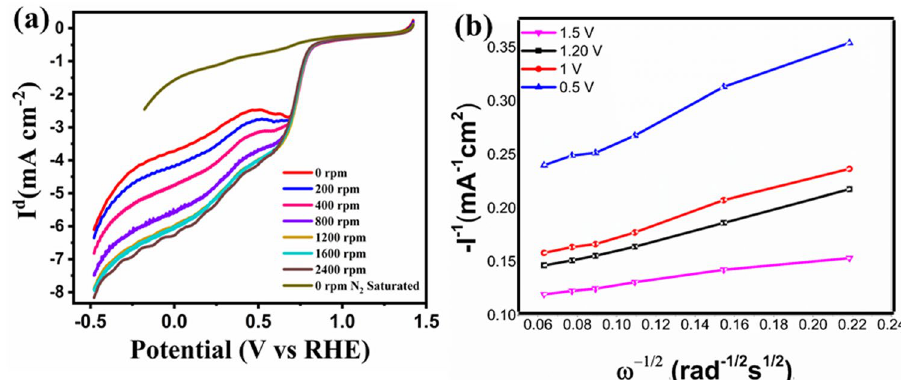
Figure 4. ORR electrochemical analysis in 0.1 M KOH solution, O 2 purged ( a ) RDE graphs of CCTO at different rotations in the potential range of 1.5 to − 0.5 V; ( b ) Koutecky–Levich graph of the material at various potentials (V).